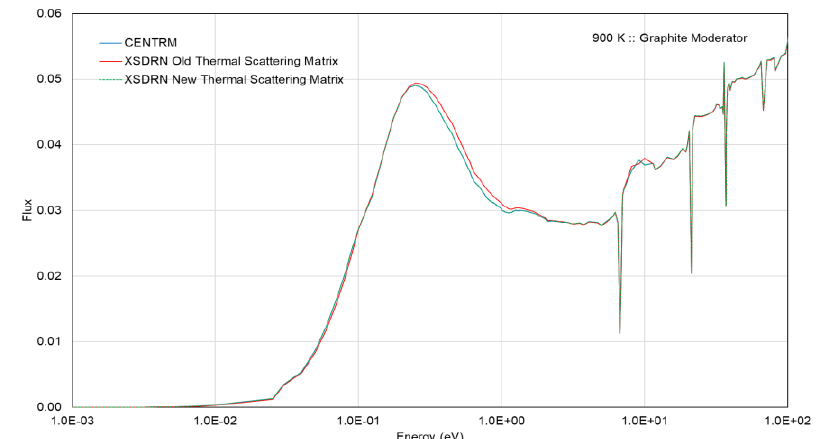
Figure 5. Comparison of thermal neutron spectra between CENTRM and